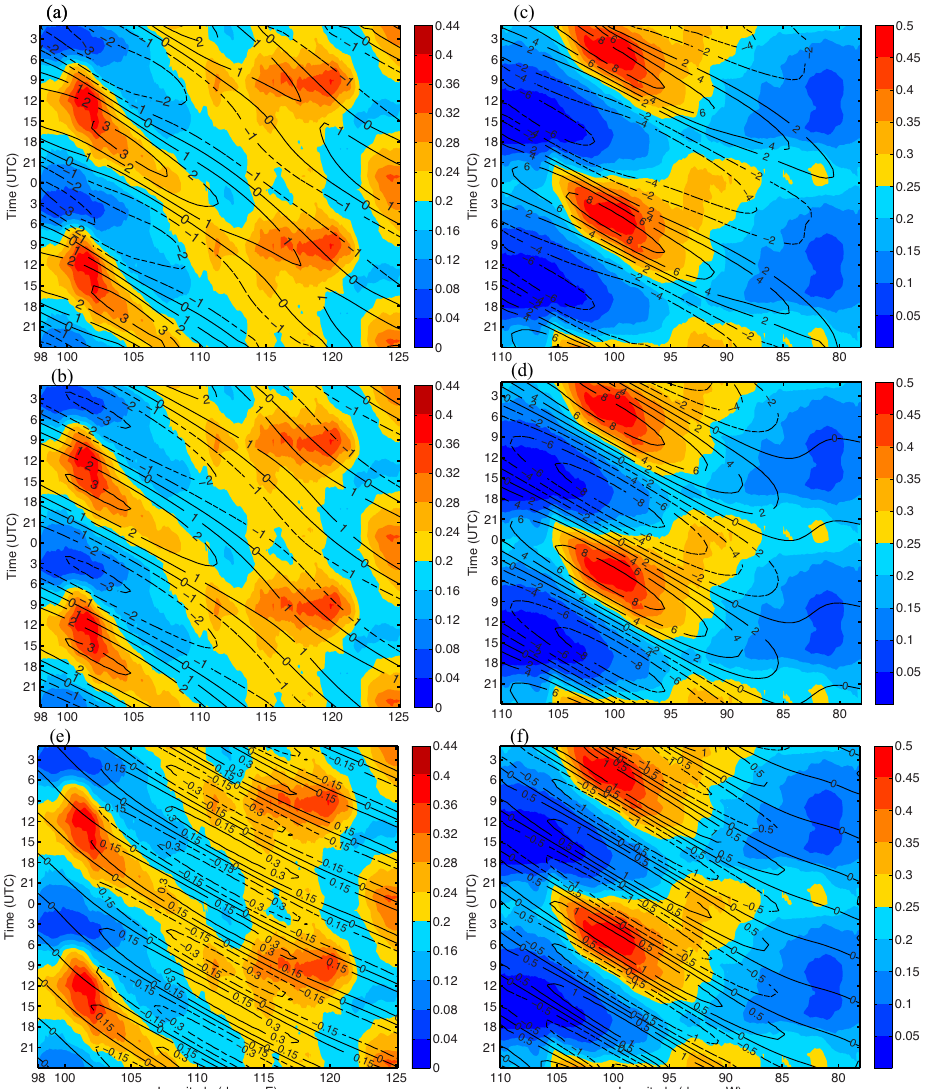
Figure 10a. Left: the time-longitude diagram of the diurnal variation in the hourly 2 precipitation (shadings, units: mm) and the filtered precipitation perturbation (multiplied 3 by 100, contours, units: mm h -­‐ 1 ) for (a) spectrally filtered for phase speeds between 10 and 4 25ms − 1 (b) SR1 derived over the focus domain in East Asia, values of contours are from -5 3 to 3 with interval of 1. Right: as in the left panels but for the filtered perturbations for (c) 6 for phase speeds between 13 and 30 ms − 1 , (d) SR1 over the focus domain in North 7 America, values of contours are from -8 to 8 with interval of 2. 8 Figure 10b. similar to Figure 10a , but left panel is SR2 derived over the focus domain in 2 Figure 10. Left: the time–longitude diagram of the diurnal variation in the hourly precipitation (shadings, units: mm) and the filtered pre- cipitation perturbation (multiplied by 100, contours, units: mmh − 1 ) in East Asia (a) spectrally filtered for phase speeds between 10 and East Asia, values of contours are from -0.3 to 0.3 with interval of 0.1, right one is SR2 3 25ms − 1 , (c) SR1 derived over the focus domain, values of contours are from − 3 to 3 with interval of 1, (c) SR2 derived over the focus domain in East Asia, values of contours are from − 0.3 to 0.3 with interval of 0.1. Right: as in the left panels but in North America (d) for over the focus domain in North America, values of contours are from -1 to 1 with interval 4 phase speeds between 13 and 30ms − 1 , (e) SR1 over the focus domain, values of contours are from − 8 to 8 with interval of 2, (f) SR2 over of 0.5. 5 the focus domain, values of contours are from − 1 to 1 with interval of